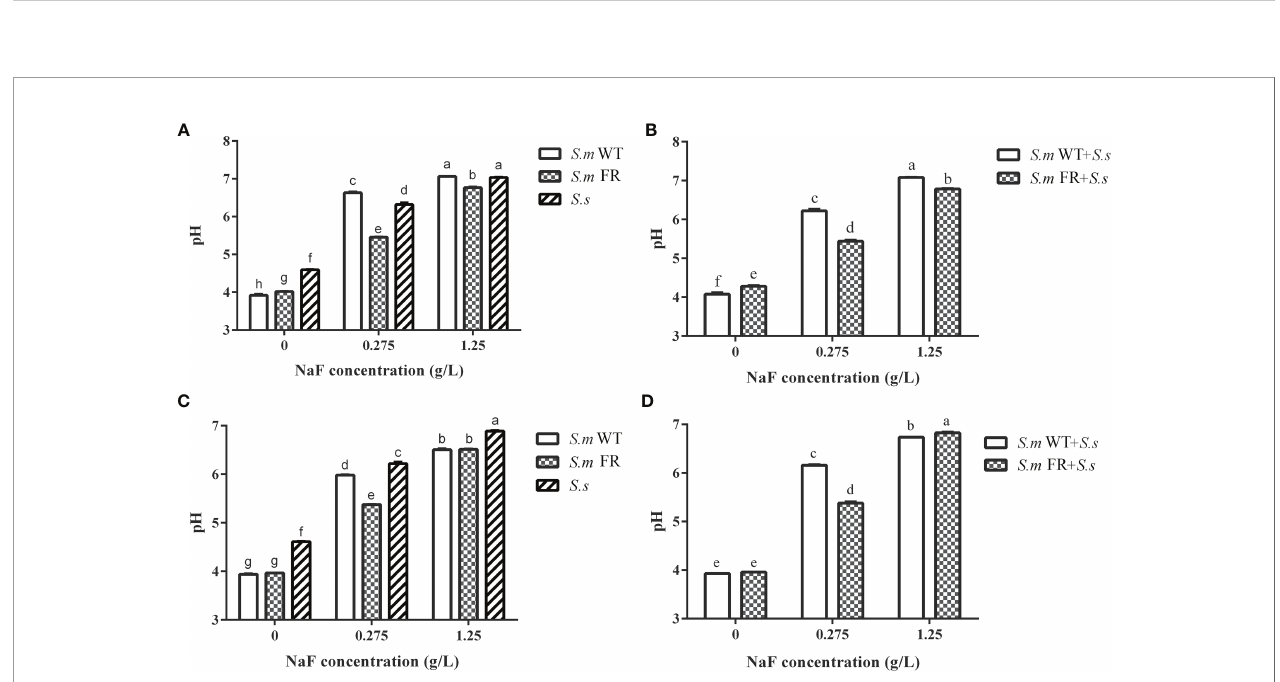
FIGURE 7 | pH of culture supernatant of bio fi lm. (A) Single-species bio fi lm formation. (B) Dual-species bio fi lm formation. (C) Pre-formed single-species bio fi lms. (D) Pre-formed dual-species bio fi lms. The same letters indicate no statistical difference, and different letters indicate a signi fi cant difference between groups ( P < 0.05).